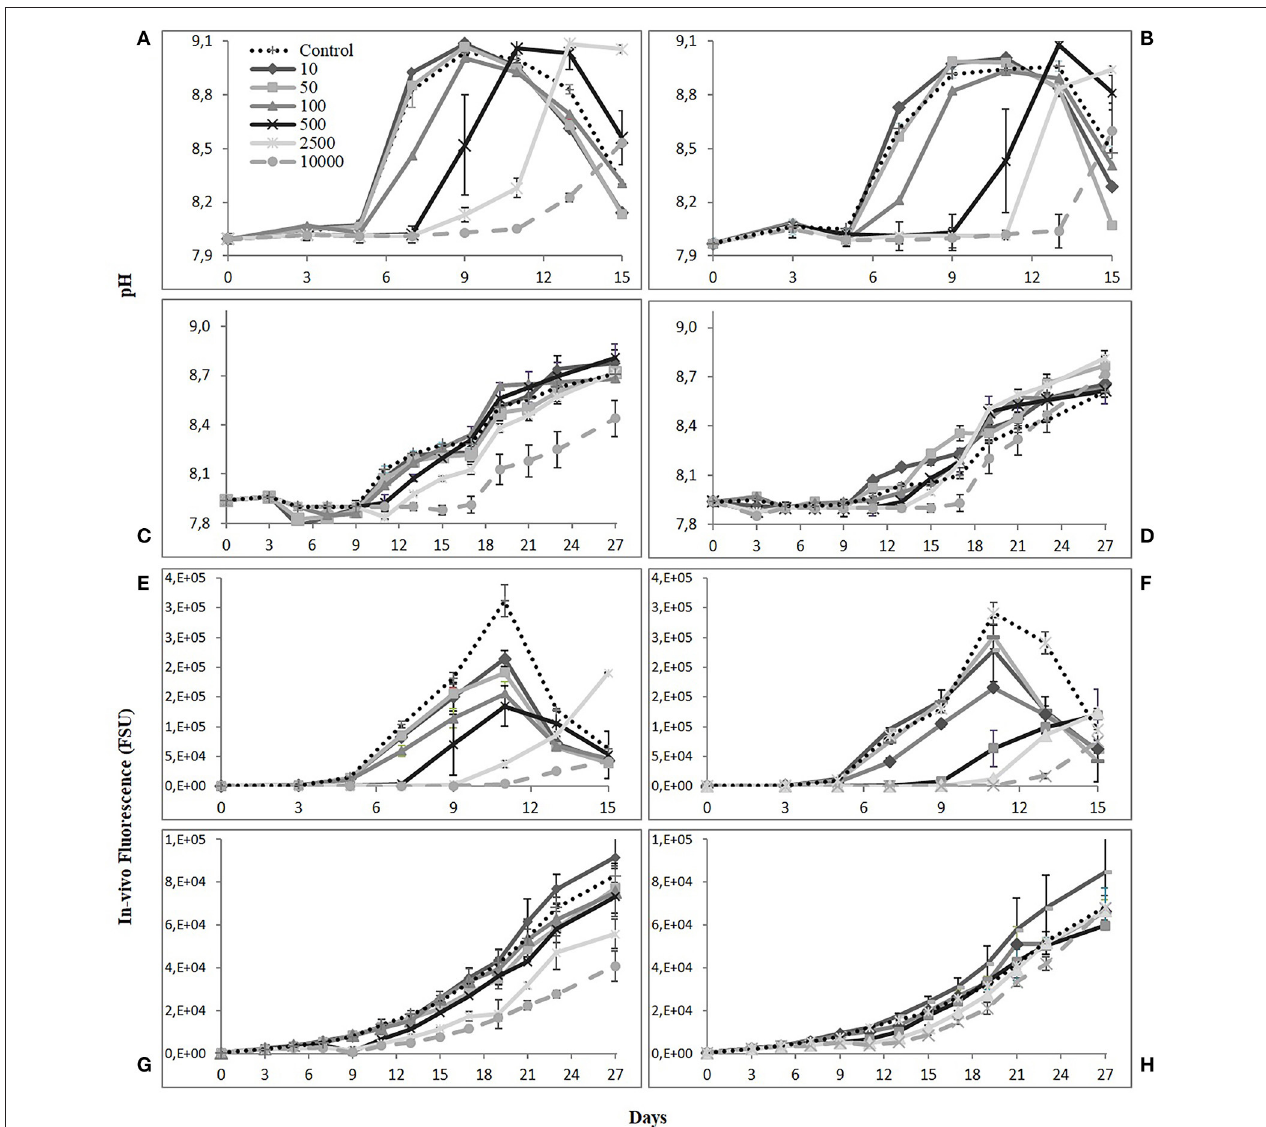
FIGURE 1 | pH and In-vivo fluorescence (FSU) for Skeletonema costatum (A,B,E,F) and Alexandrium catenella cultures (C,D,G,H) over time. Left graphs (1nM Fe) and right graphs (10nM Fe). Error bars: standard deviation ( n = 3).